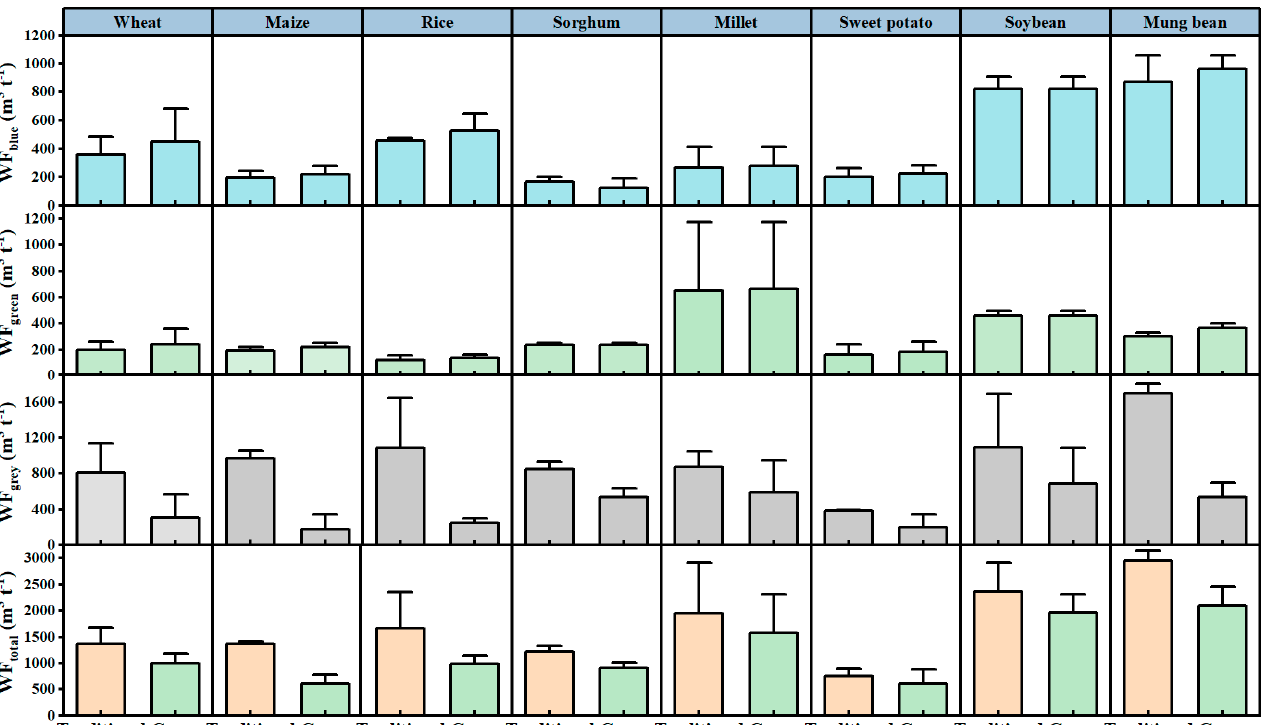
Figure 6. Comparison of the water footprint of each crop under green and traditional cultivations in the Huang-Huai-Hai farming region.